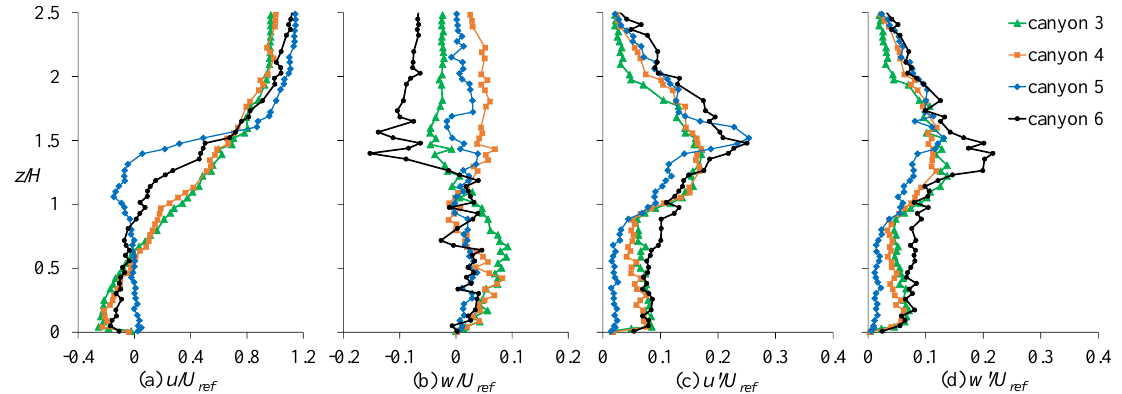
Figure 7. Normalized middle-line velocity profiles of canyons 3–6 with a reversed wind catcher above canyon 4. ( a ) Mean stream-wise velocity, ( b ) mean vertical velocity, ( c ) stream-wise velocity fluctuation, and ( d ) vertical velocity